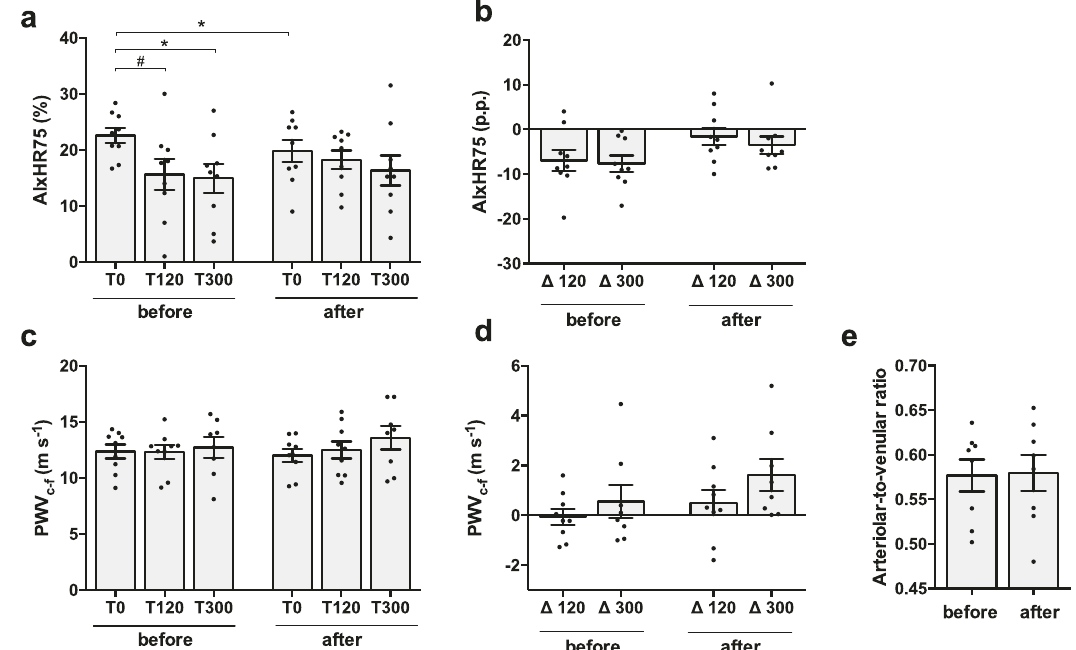
Fig. 4 Vascular function markers. a Aortic augmentation index (AIxHR75) at timepoints T0, T120, T300 ( n = 9), before T0 vs. after T0 p = 0.03, before T0 vs. before T120 p = 0.10, before T0 vs. before T300 p = 0.02. b AIxHR75 delta ’ s T0-120 and T0-300 expressed as percentage points ( n = 9). c Pulse wave velocity (PWV c-f ) at timepoints T0, T120, T300 ( n = 8 at T300). d PWV c-f delta ’ s T0-120 and T0-300 ( n = 8 at delta T0-300). e Arteriolar-to- venular ratio of the retinal vessels in the right eye ( n = 8). Data was analyzed with a two-sided Wilcoxon matched-pairs signed rank test. Data shown are shown as individual datapoints and mean ± SE. * p < 0.05, # p < 0.10.